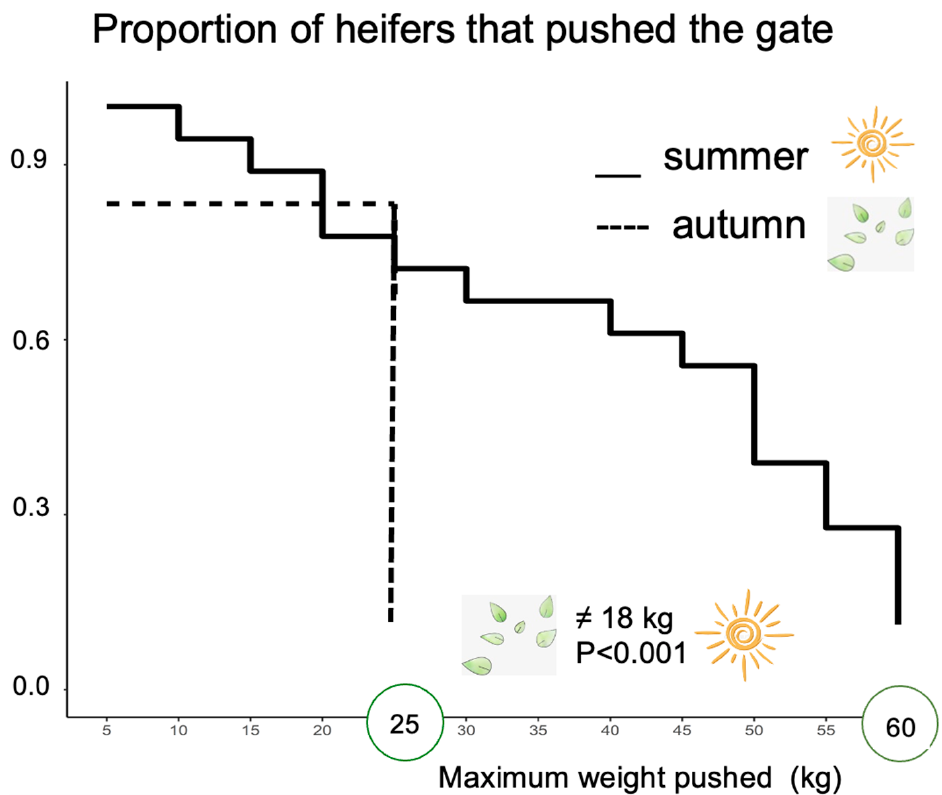
Figure 2. A step graphic for pasture housed heifers’ ( n = 18) willingness to work (maximum weight pushed) for access to an area with an open dry lot area and a shaded area during the summer (solid line) vs. autumn (dashed line). Maximum weight pushed to access shade was stronger in the summer compared to the autumn ( p < 0.01).